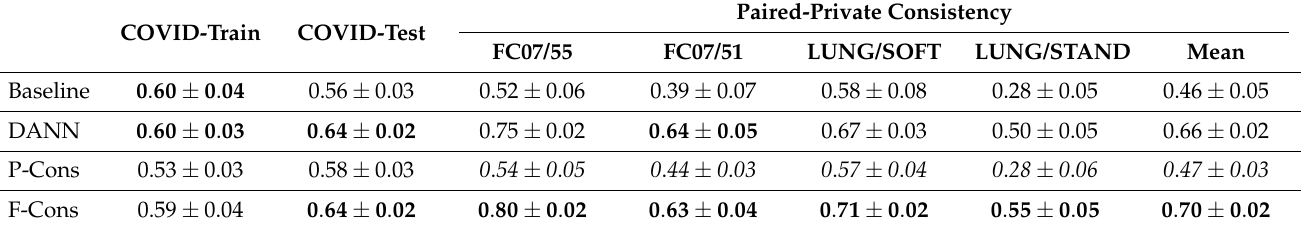
Table 5. Comparison of all adaptation methods from Table 3 except FBPAug trained on the Public- paired dataset. All results are Dice Scores in the format mean ± std calculated from 5-fold cross- validation. We highlight the consistency scores near or below Baseline level in italic . The best consistency scores are highlighted in bold